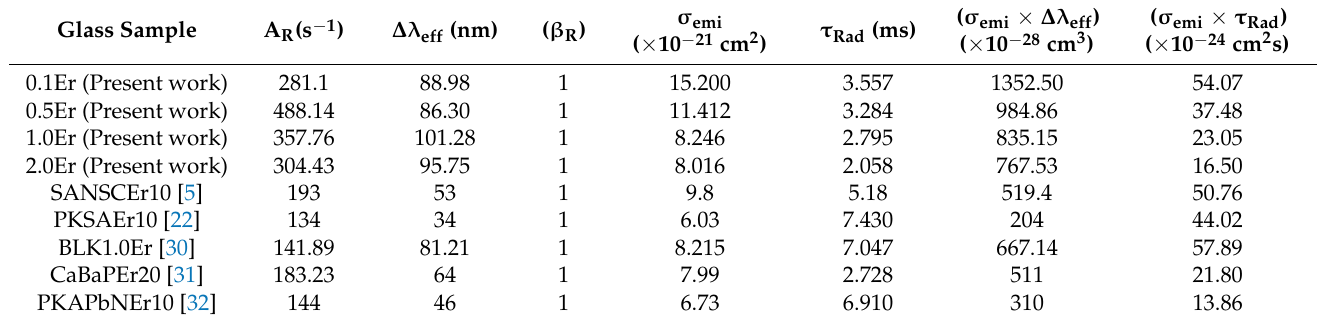
Table 4. Radiative properties for 4 I 13/2 → 4 I 15/2 of Er 3+ ions doped ZBB glasses along with other re- ported glasses.